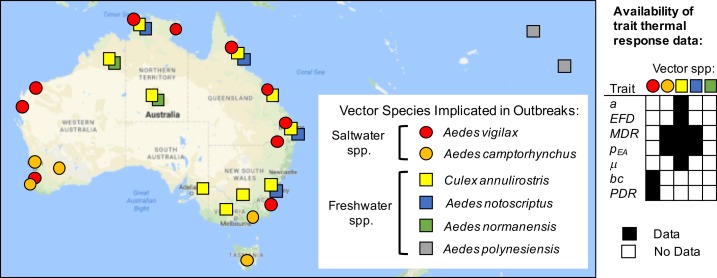
Vector species implicated in RRV disease outbreaks.Map of specific mosquito species identified as important vectors based on collected field specimens. Grid (right) shows data availability of trait thermal responses for the five Australian species. Data sources listed in Figure 1—source data 1. Trait parameters are biting rate (a), fecundity (as eggs per female per day, EFD), mosquito development rate (MDR), the proportion surviving from egg-to-adulthood (pEA), adult mosquito mortality (μ = 1/lifespan), vector competence (bc), and parasite development rate (PDR).10.7554/eLife.37762.004Figure 1—source data 1.Vector species implicated in RRV disease outbreaks.Location and year of RRV disease outbreaks and mosquito species identified as likely vectors based on the collection of field specimens. Only the six most important mosquito species are included. Citation key: A: Biggs and Mottram, 2008; B: Brokenshire et al., 2000; C: Campbell et al., 1989; D: Dhileepan, 1996; E: Frances et al., 2004; F: Harley et al., 2000; G: Harley et al., 2001; H: Jacups et al., 2008b; I: Kelly-Hope et al., 2004b; J: Lau et al., 2017; K: Yang et al., 2009; L: Lindsay et al., 1993b; M: Lindsay et al., 1993a; N: Lindsay et al., 1996; O: Lindsay et al., 2007; P: McDonnell et al., 1994; Q: McManus et al., 1992; R: Merianos et al., 1992; S: Ritchie et al., 1997; T: Rosen et al., 1981; U: Russell et al., 1991; V: Russell, 1994; W: Russell, 2002; X: Ryan et al., 2000; Y: Schmaedick et al., 2008; Z: Whelan et al., 1992; AA: Whelan et al., 1995; AB: Whelan et al., 1997.